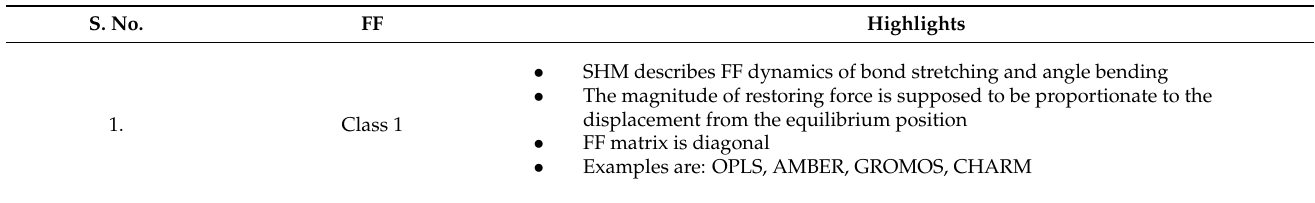
Table 7. The different classes of force fields (FF) in the simulation of molecular